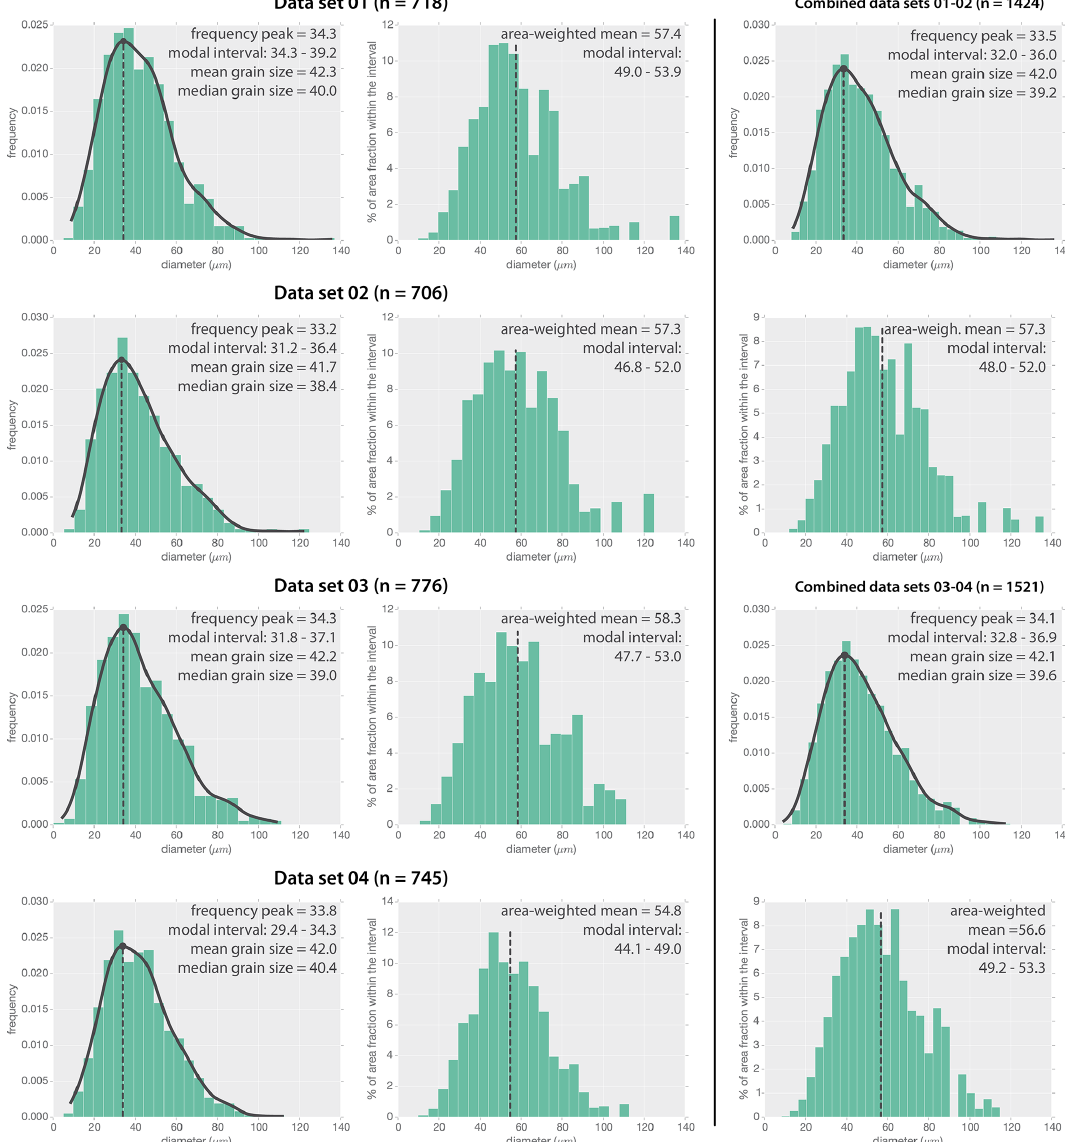
Figure 10. Testing reproducibility of GrainSizeTools script using different sub-data sets from the natural sample